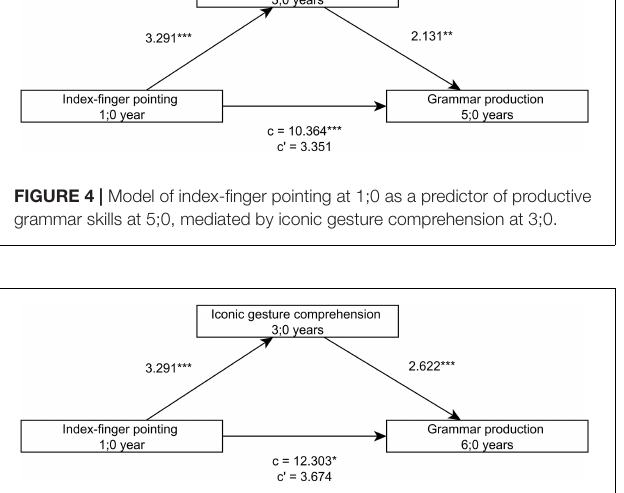
between the two groups are highly driven by the results of the two children with the apparent DLD. Excluding the two children with a DLD from the analyses, no differences between TD children and children with a history of LD were found in the word production task ( Figure 6 ) but in the area of sentence comprehension, grammar production, and sentence repetition at 5;0 ( Table 5 ). At the age of 6;0, no more differences in the language skills between the two groups are found when the two children with DLD are excluded from the analyses ( Table 5 ).